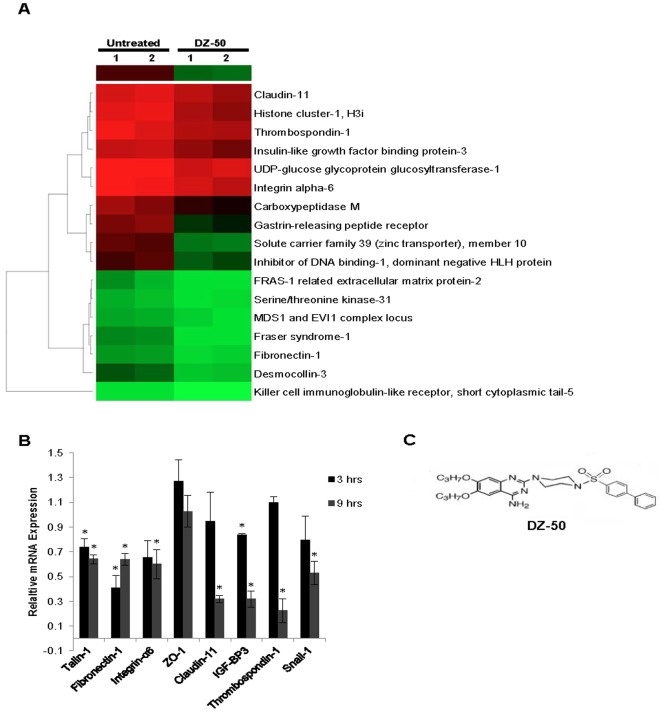
Genes targeted by DZ-50 in prostate cancer cells.Panel A, Heat map of differentially expressed genes in DU-145 human prostate cancer cells before and after treatment with DZ-50 (9 hrs). We identified 17 markedly downregulated genes following treatment with DZ-50 (9 hrs), including genes encoding for ECM regulators fibronectin and integrin α6, tight junction mediator Claudin-11 and angiogenesis signaling effector thrombospondin 1. (fold change >1.5, false discovery rate <20%). Panel B, Validation of gene expression using qRT-PCR after DZ-50 treatment of prostate cancer cells (5 µM) for 3 and 9 hrs. A significant reduction in mRNA relative to untreated cells was detected for genes involved in ECM-focal adhesion signaling components (fibronectin, integrin-α6 and talin), tight junctions (claudin-11), angiogenesis (thrombospondin-1) and EMT (Snail). *indicates significant difference at p<0.05. Panel C, Molecular structure of the Doxazosin© derivative, DZ-50.